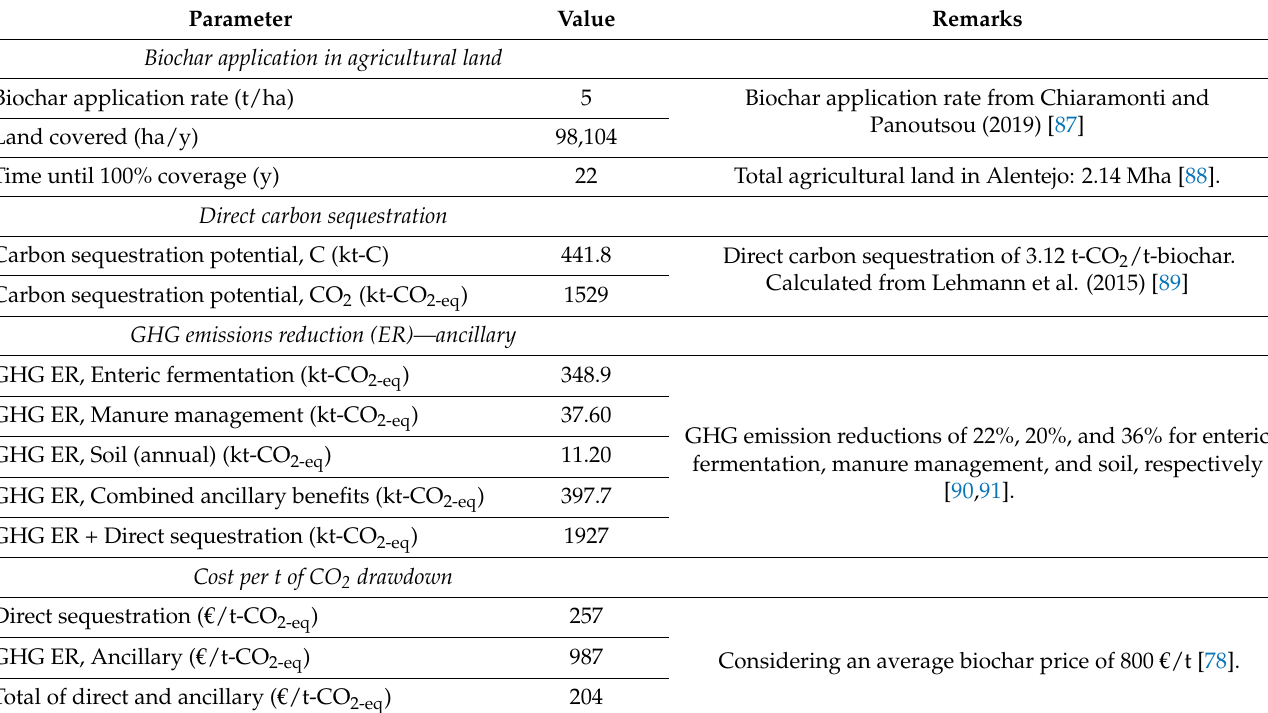
Table 11. Estimated benefits of the potential application of biochar in Alentejo agricultural lands considering 100% of the technical biomass potential. Methodology from Pacific Biochar